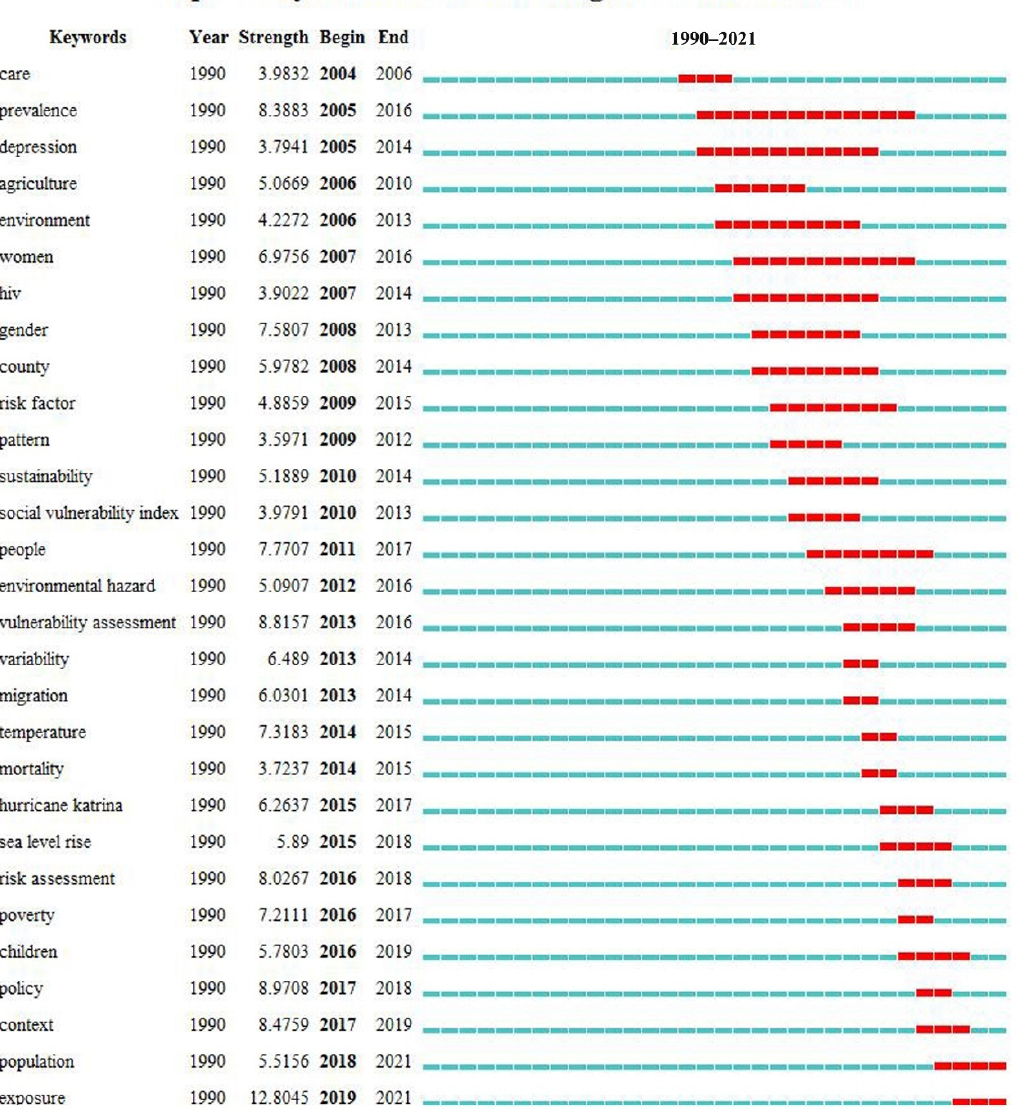
Figure 4. Top 29 keywords with the strongest citation bursts from 1990 to 2021.